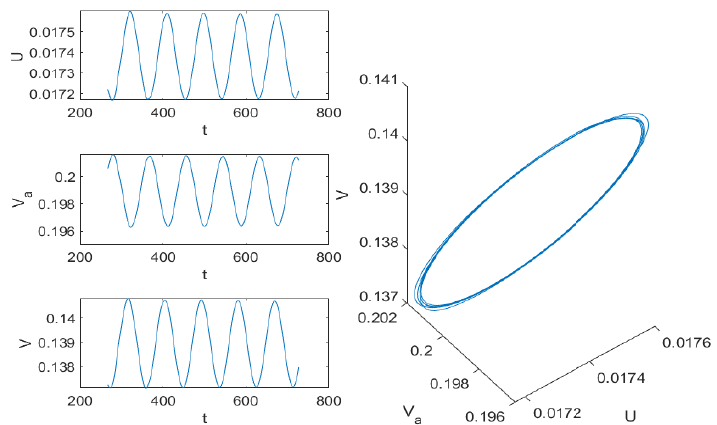
Figure 8. When τ = 35.5, the periodic solution of system (1) near equilibrium P is stable. It can be seen from Figures 6–8, the equilibrium P of system (1) is locally asymptotically stable as shown in Figures 6 and 7. The equilibrium P of system (1) is unstable when ( 0 ) τ ∈ ( τ , + ∞ ) . The equilibrium P of system (1) exhibits periodic fluctuation and bifurcates 1 stable periodic solutions when τ approaches the critical time τ